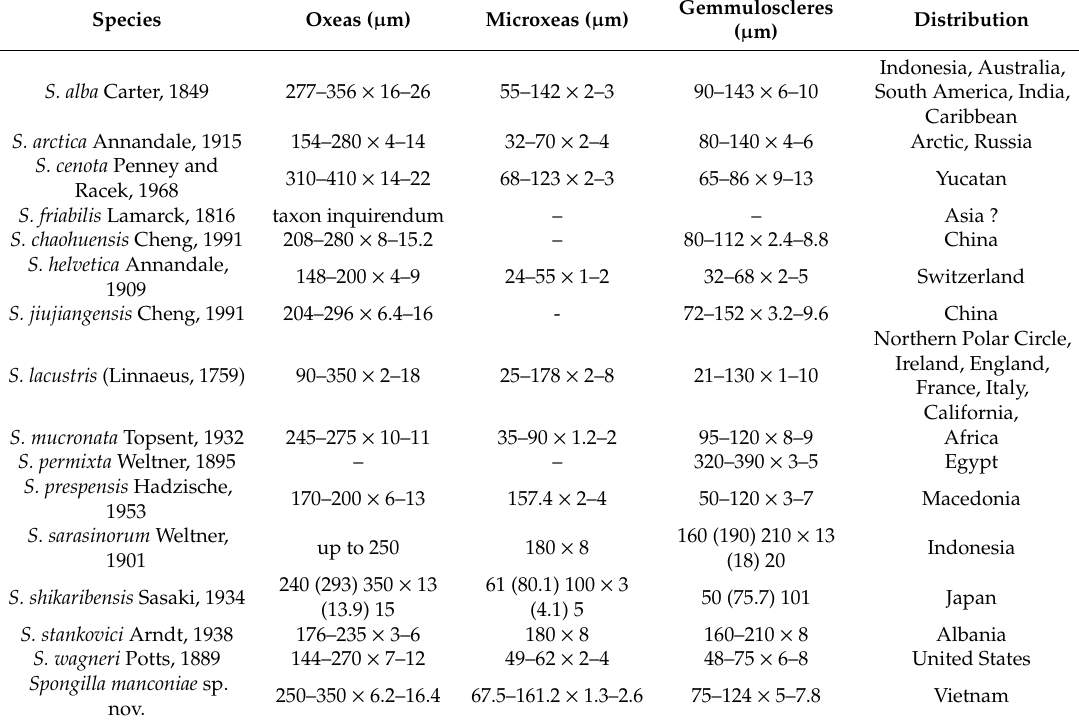
Table 3. Comparison of the spicule dimensions of Spongilla manconiae sp. nov. with the other known Spongilla species. Geographical distributions were checked in the World Porifera Data Base